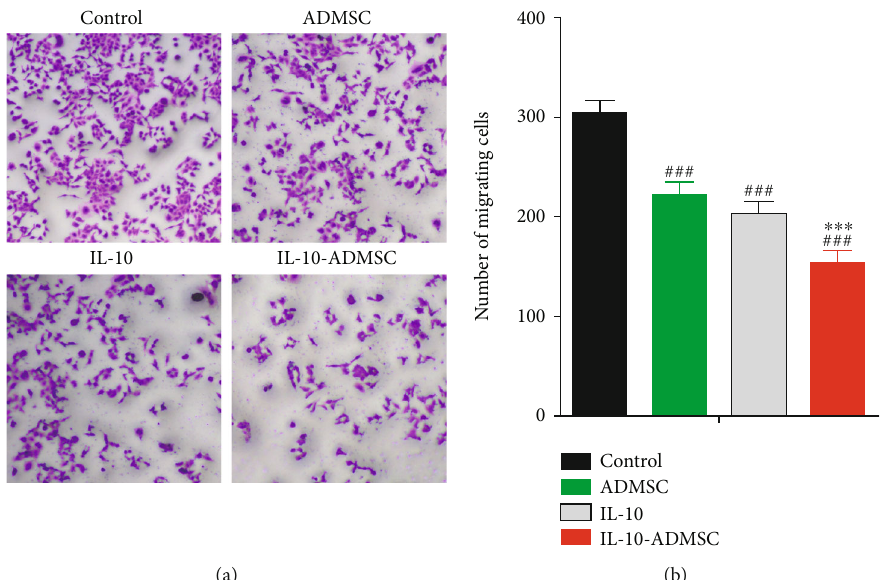
Figure 3: IL-10-modi fi ed ADMSC inhibited the migration of HSFs. HSFs were cultured alone, or added 1 μ g/L IL-10 in the medium, or cocultured with ADMSC/IL-10-ADMSC for 3 days, and then, Transwell test was used to evaluate the migration ability of HSFs in a cocultivation system of ADMSC and HSFs, and representative migration maps were displayed (a) and statistically compared the number of migrated cells in each group (b). Scale bar: 25 μ m. Data was expressed as ( SD ± mean ), and each analysis was repeated at least 3 times independently; P value was calculated by one-way ANOVA; ∗∗∗ was P < 0 : 001 vs. ADMSC group; ### was P < 0 : 001 vs. control